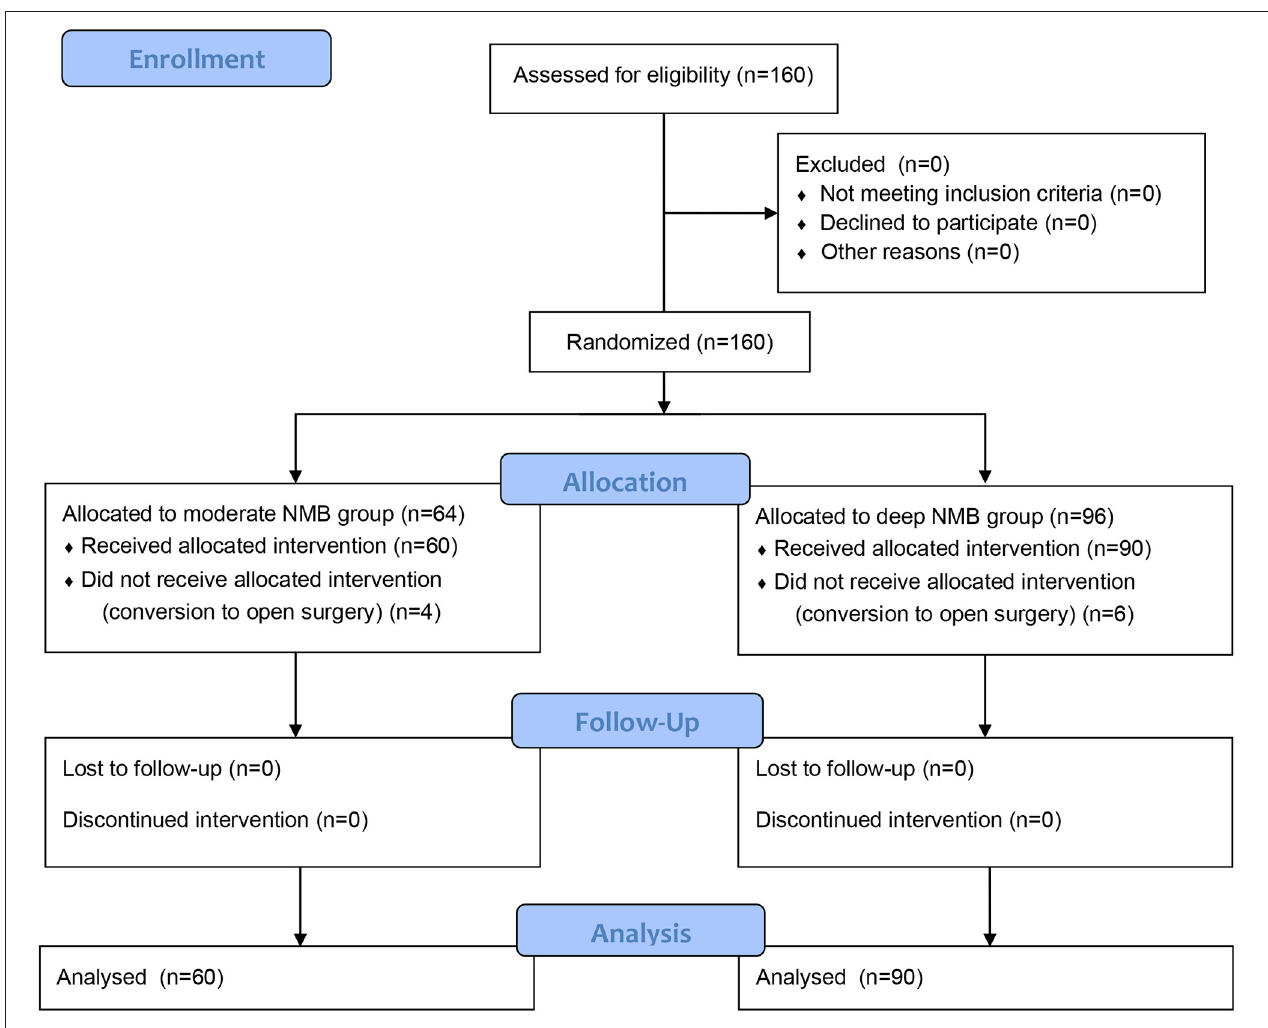
FIGURE 1 | Flowchart of the